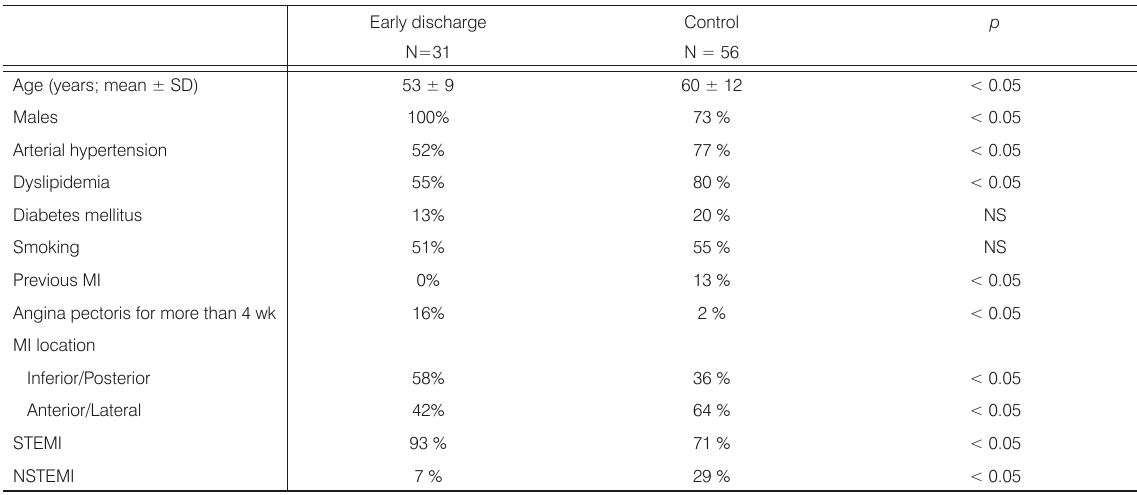
Table 1. Baseline clinical and demographic characteristics of patient population. Results are presented as percentage if not stated